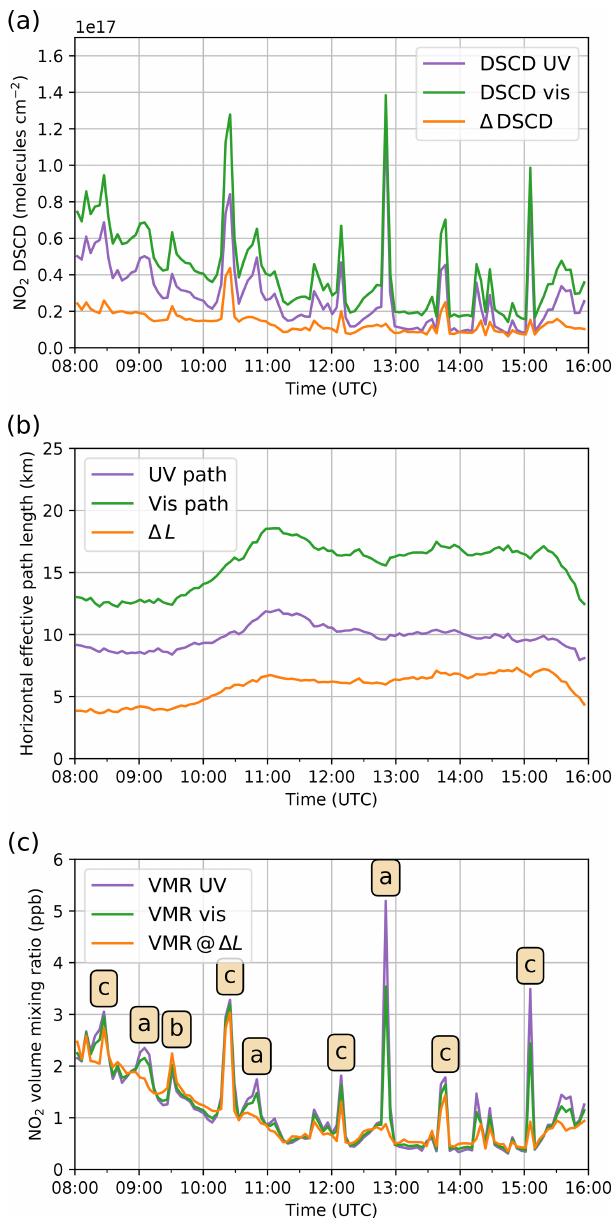
Figure 3. Differential slant column densities of NO 2 (a) , horizon- tal effective path lengths (b) , and horizontal path-averaged volume mixing ratios of NO 2 on 26 May 2014 in 0.5 ◦ elevation and 335 ◦ azimuth for the UV (purple) and visible spectral ranges (green) and their difference (orange) (c)